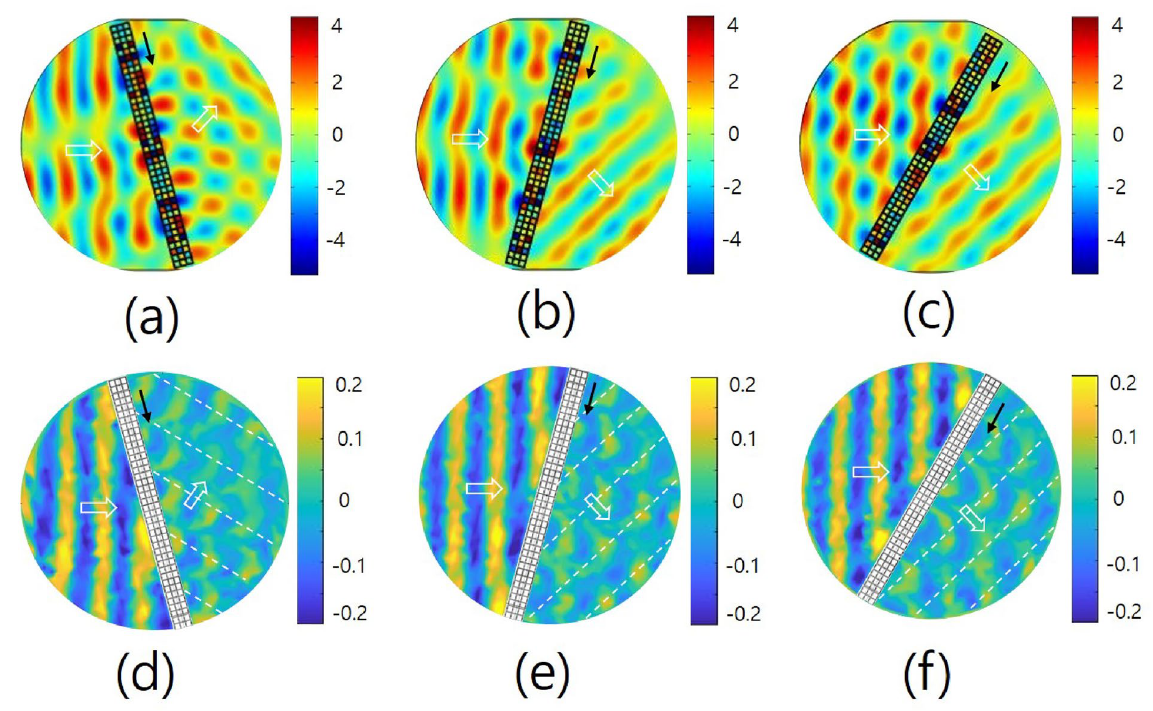
Figure 6. Propagations of sound waves after passing through the metasurface with respect to the incident angles for the metasurface at the characteristic frequency of 2000 Hz. ( a – c ) are the results of the numerical simulation, and ( d – f ) are the corresponding results of the experimental measurement. The incident angles of sound waves of ( a )–( c ) are − 15 ◦ , + 15 ◦ and + 30 ◦ , respectively. The experimental (theoretical) values of refractive angles are determined as 40 ◦ ( 30.8 ◦ ) , − 33 ◦ ( − 30.8 ◦ ) and − 15 ◦ ( − 15.7 ◦ ) ,